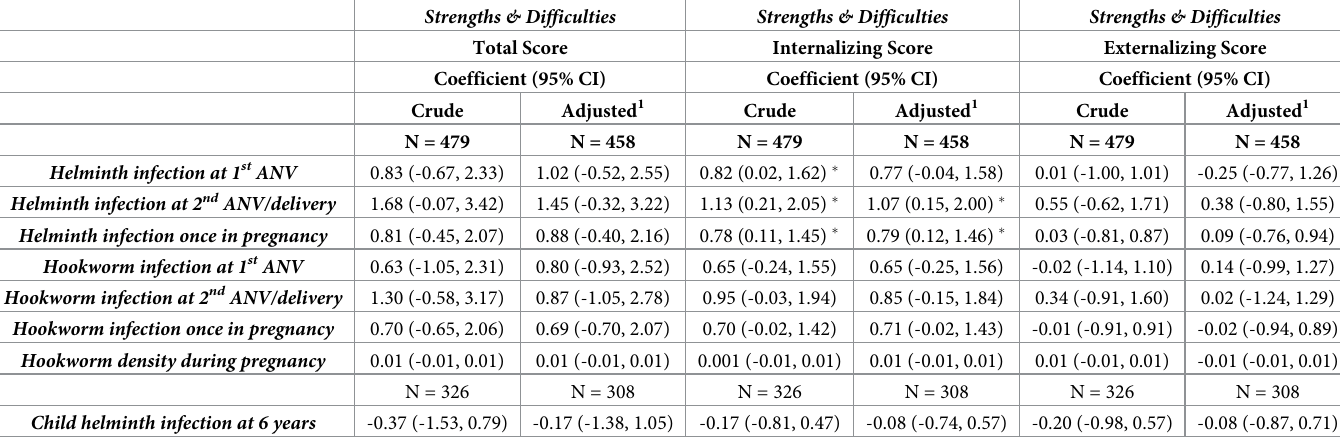
Table 4. Multiple linear regression models between SHIP and child behavioral and emotional development scores at six